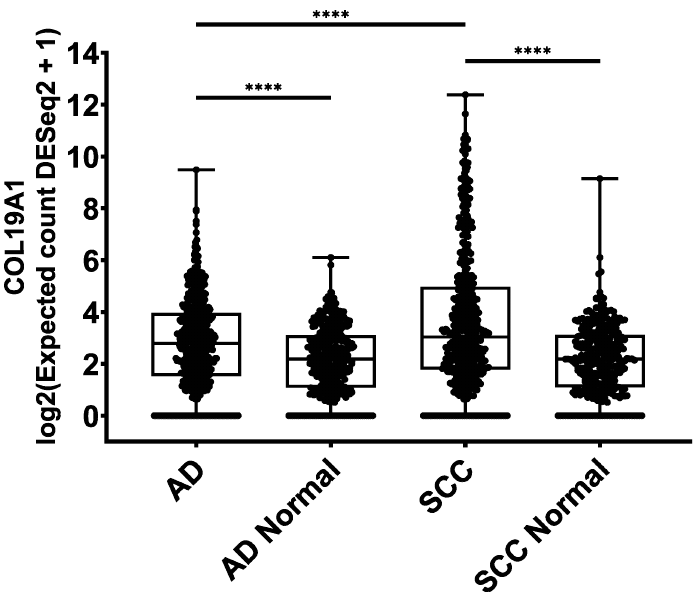
Figure 4. COL19A1 gene expression from the The Cancer Genome Atlas (TCGA) and Genotype-Tissue Expression (GTEx) databases in AD (n = 513), AD normal ( n = 347), SCC ( n = 498) and SCC normal ( n = 338). The AD and SCC normal groups included normal samples from GTEx and tumor-adjacent normal samples from AD and SCC patients, respectively.